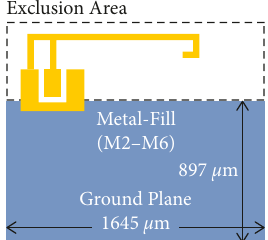
Figure 4: Top view of the proposed OCA depicting designated exclusion area along with dummy metal-fill region and the ground plane.